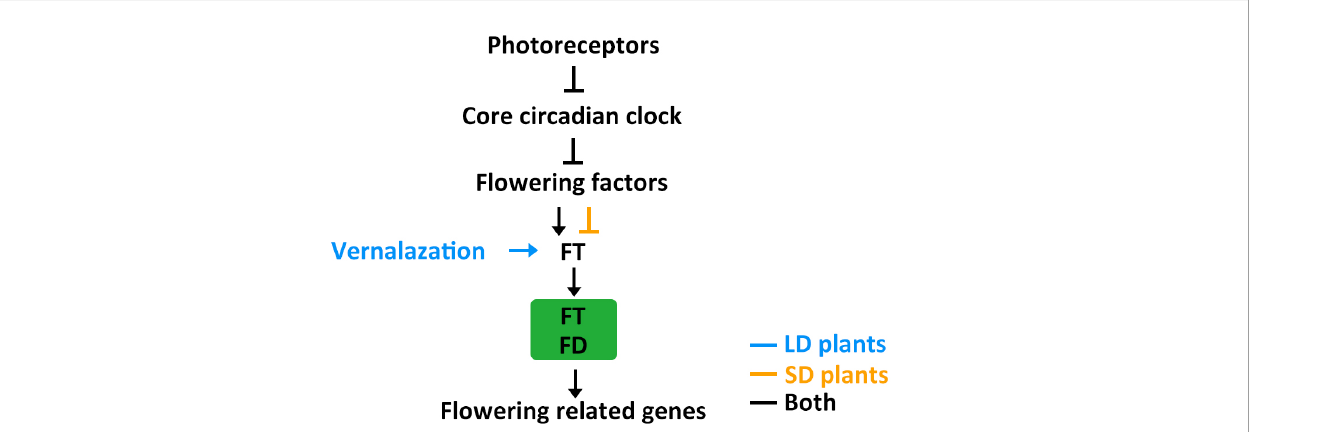
FIGURE 4 The putative model of fl owering regulatory module in LD crops and SD crops. Positive and negative regulatory actions are indicated by arrows and lines with bares,